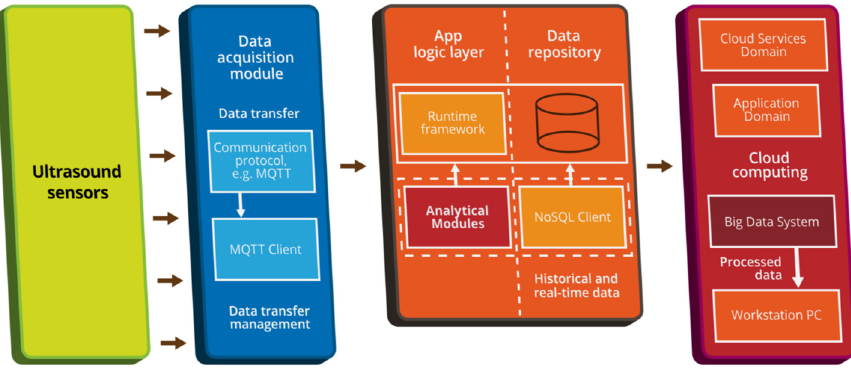
Figure 3. System structure model for cloud computing data processing, acquisition, collection, and analysis